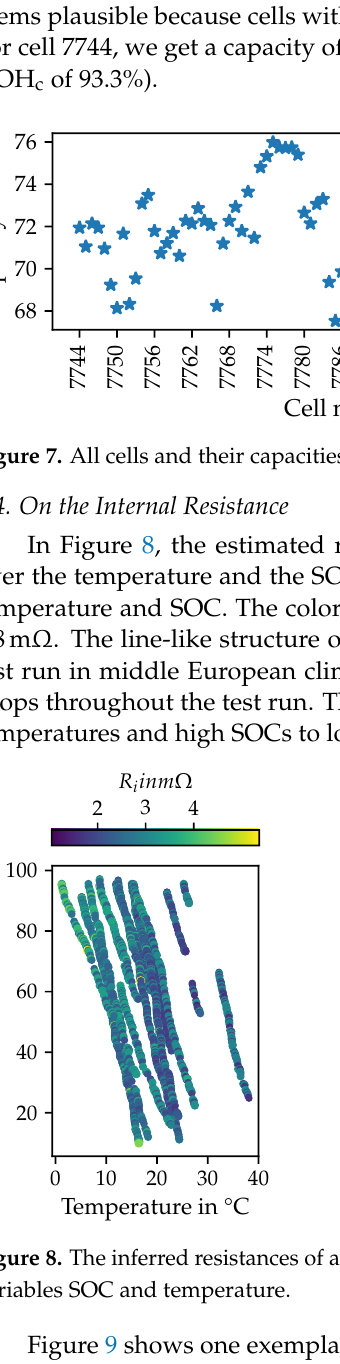
Figure 9. Example fitting result of one 30s cycle measurement. A RMSE of 1.23mV indicates a good model fit with the original data. Positive currents correspond to a discharge of the battery.